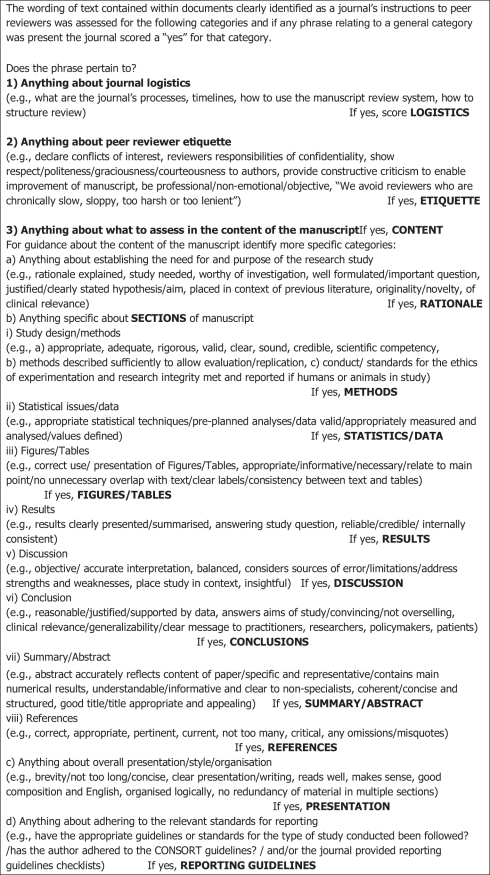
Classification of the texta contained within journal instructions to peer reviewers.